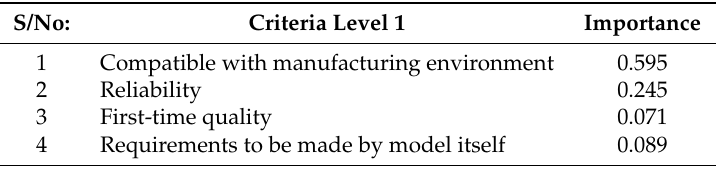
Table 3. Level 1